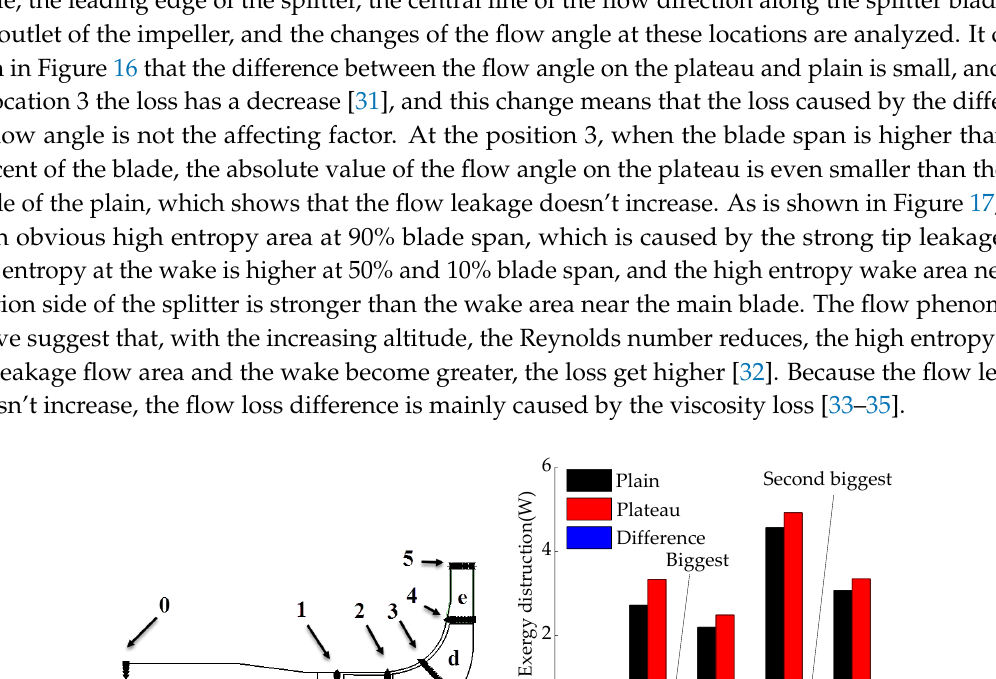
Figure 15. Exergy destruction comparison analysis: ( a ) Sections of the compressor passage; ( b ) Exergy destruction in the compressor.